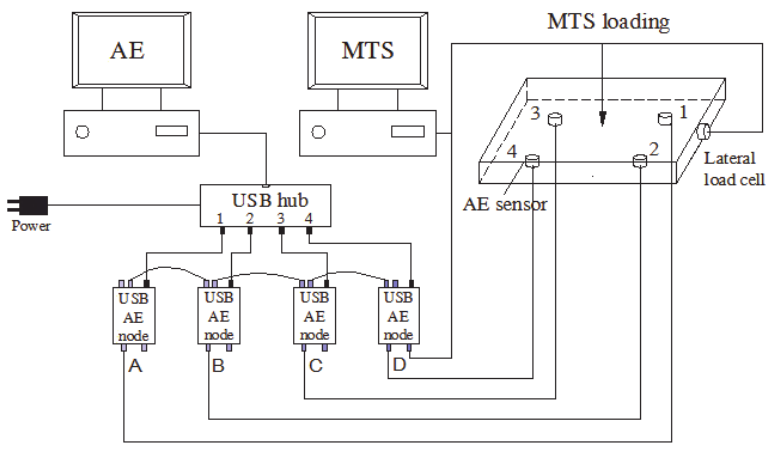
Figure 2: MTS and AE monitoring system